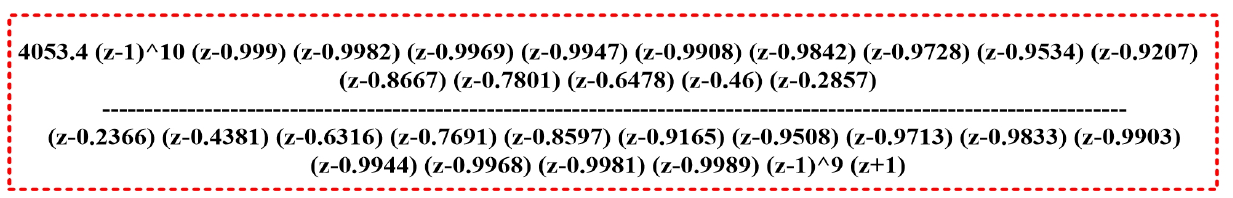
Figure A3. Transfer functions discrete and integer expression of s 1.1 .